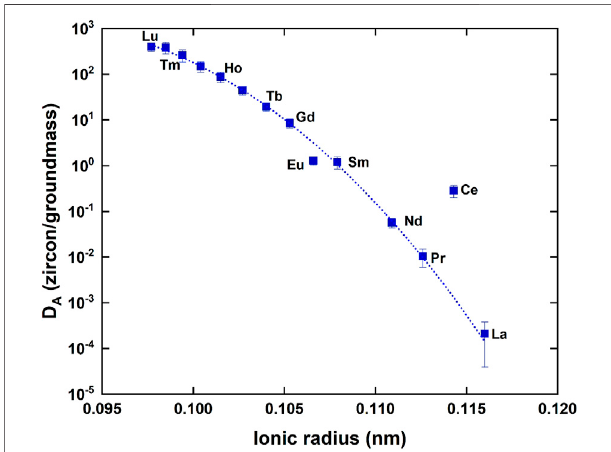
FIGURE 4 | A correlation diagram between the ionic radius of rare earth element and the partition coef fi cient (DA) between zircon and melt. Error assigned to the symbol is 2 σ . A dotted curve shows a best fi t of Eq. 3 by a least-squares method where Ce and Eu data are masked.